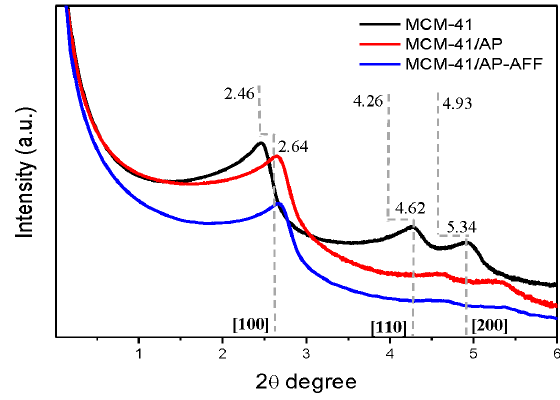
Figure 3 . Small angle XRD patterns of MCM-41, MCM-41/AP and MCM-41/AP-FFA. Figure 3. Small angle XRD patterns of MCM-41, MCM-41/AP and Table 2. Structural properties of the MCM-41 and functionalized samples calculated, from the positions of the (110) plane reflections.